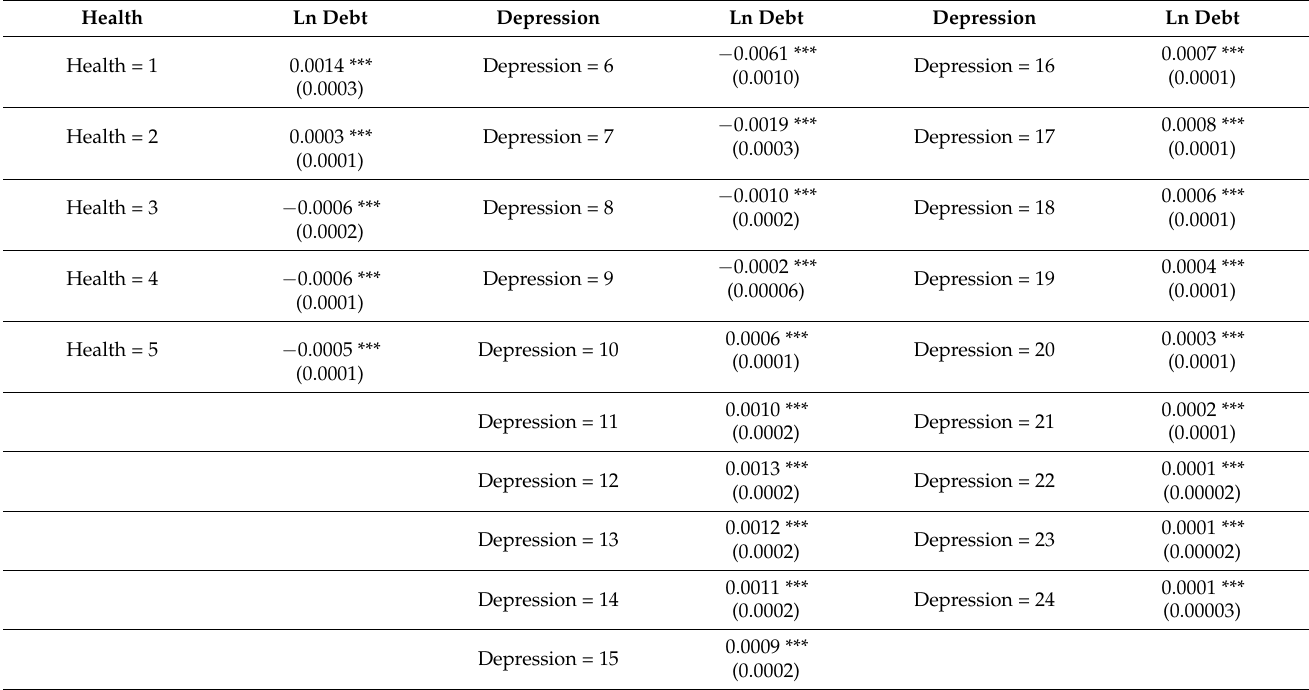
Table A8. Marginal effects of household debt in high income